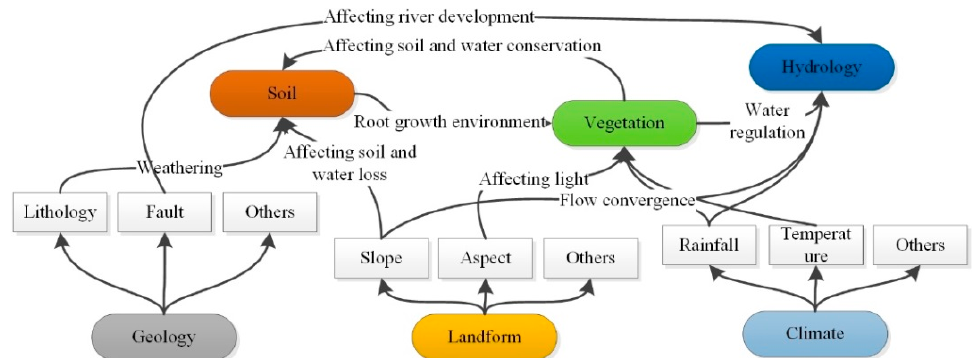
Figure 1. Factor “tree” of mountain-hazards developing environments and effects of geology, landform and climate factors for the formation of mountain-hazards developing environments. There may be obvious differences in hazards-developing environments of mountain hazards in different regions of large areas [36,37]. This requires us to study the regionalization of hazards-developing environments in order to reflect the regional differences. However, natural elements are full of complexity. Through the analysis of the relationship between various factors, finding out the most important factors is an important step to realize the difference analysis of hazards-developing environments.